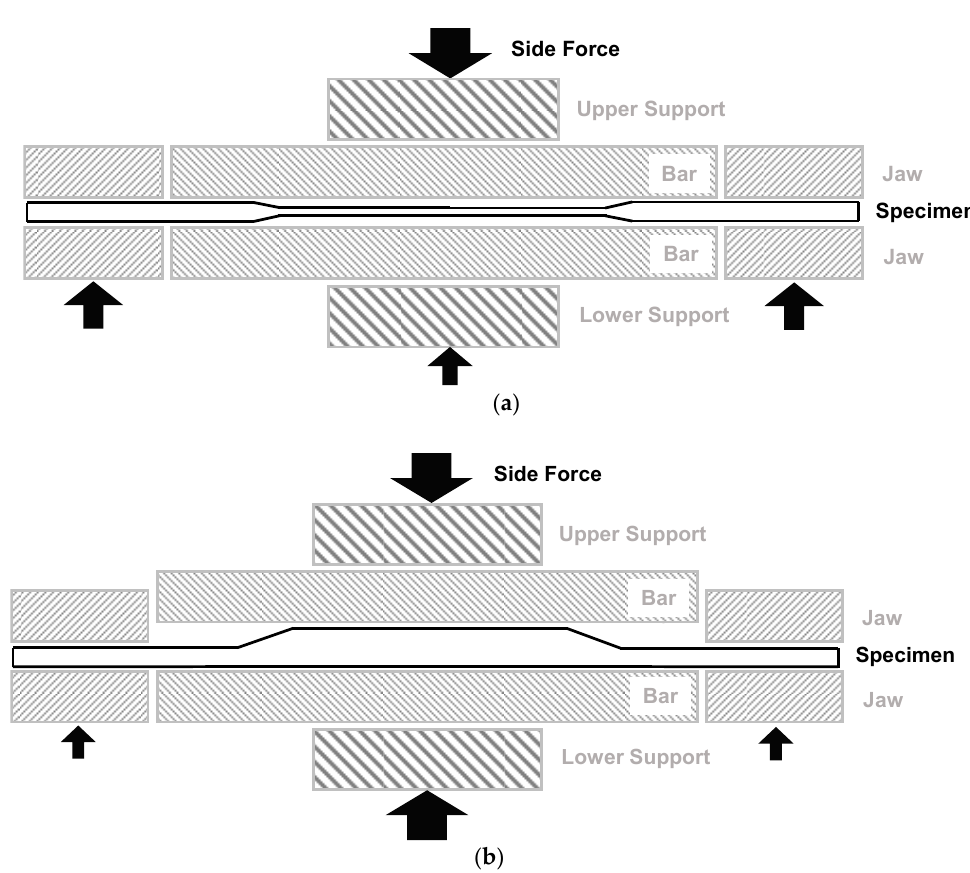
Figure 11. Schematic representation of the ( a ) thinning and ( b ) thickening of the specimen during tension and compression, respectively.